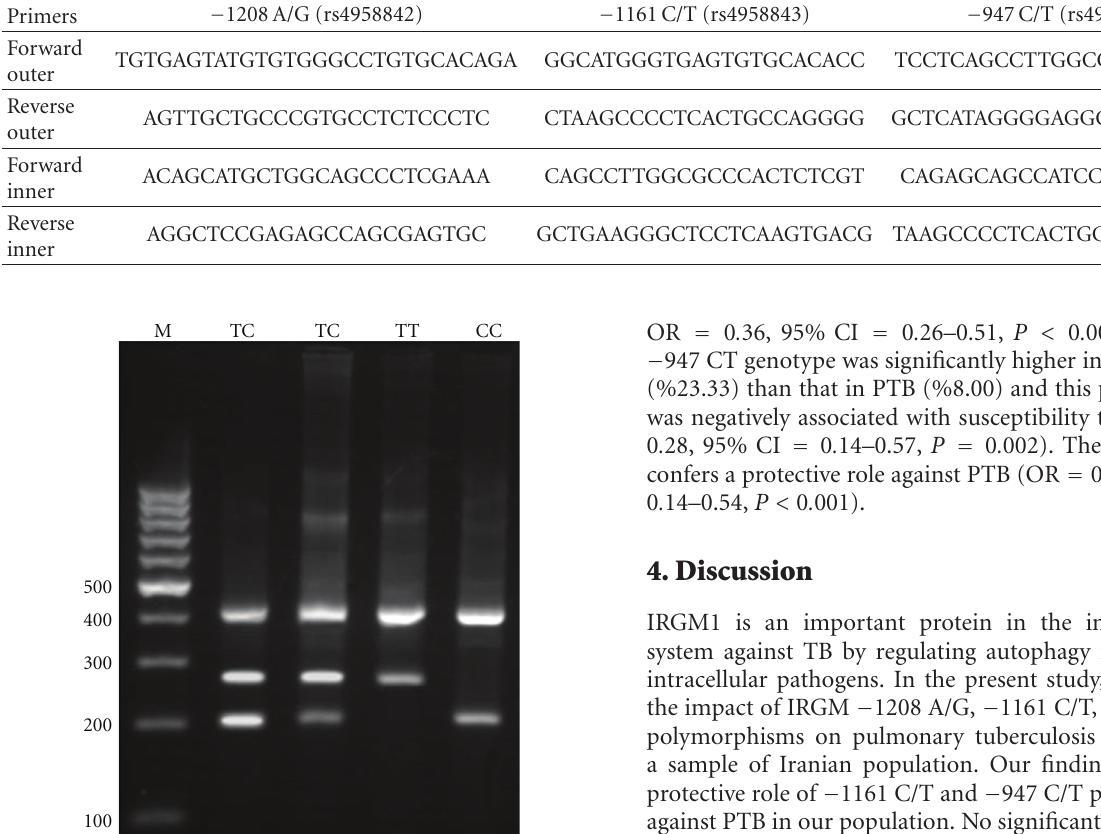
Figure 3: Electrophoresis pattern of tetra-amplification refractory mutation system-polymerase chain reaction (tetra ARMS-PCR) for detection of SNP in IRGM − 947 C/T. M : DNA marker. Product sizes were 201 bp for C allele, 263bp for T allele, and 417 bp for control